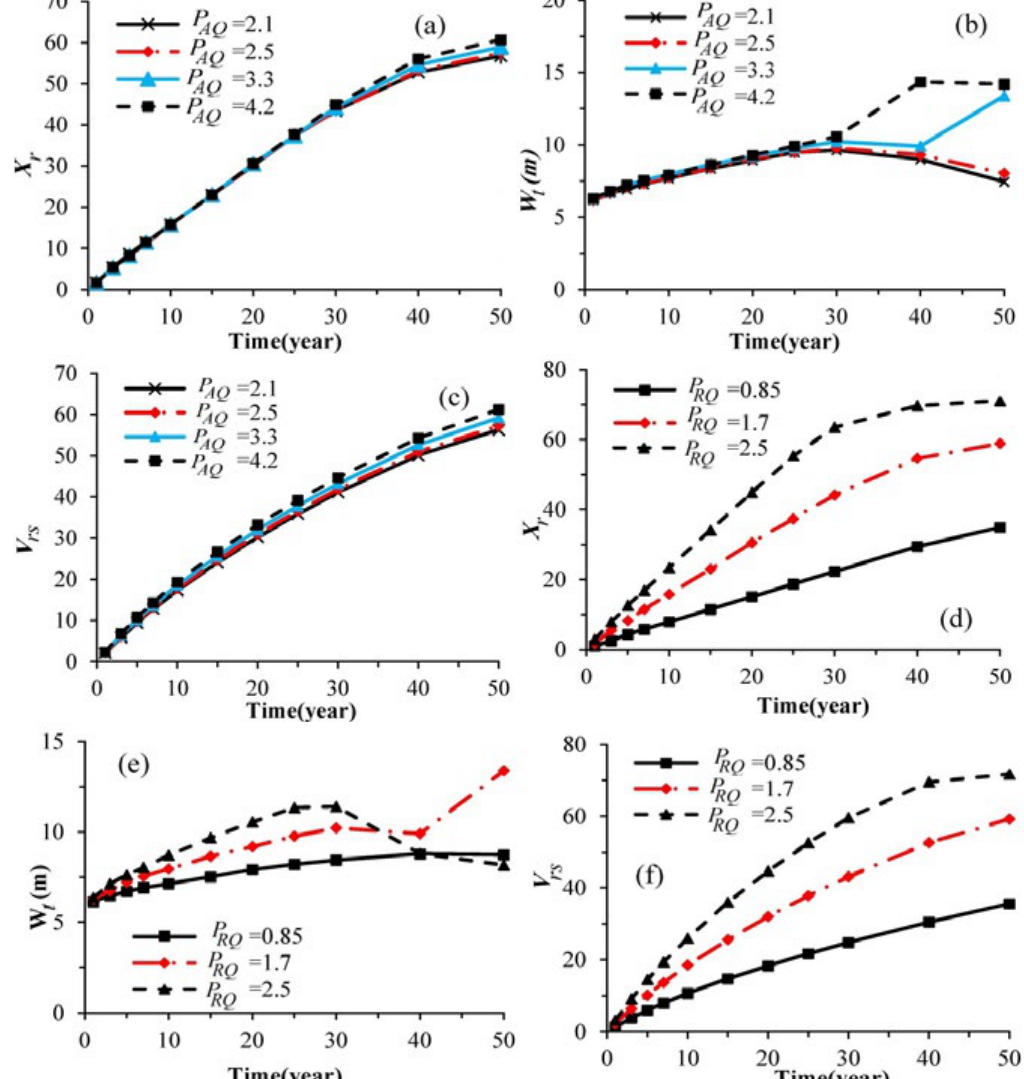
Fig. 3: The ADR efficiency (a), (b), (c) for different abstraction rate and (d), (e) and (f) for different recharge rate